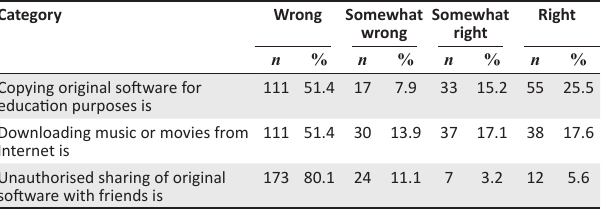
Somewhat Right wrong right